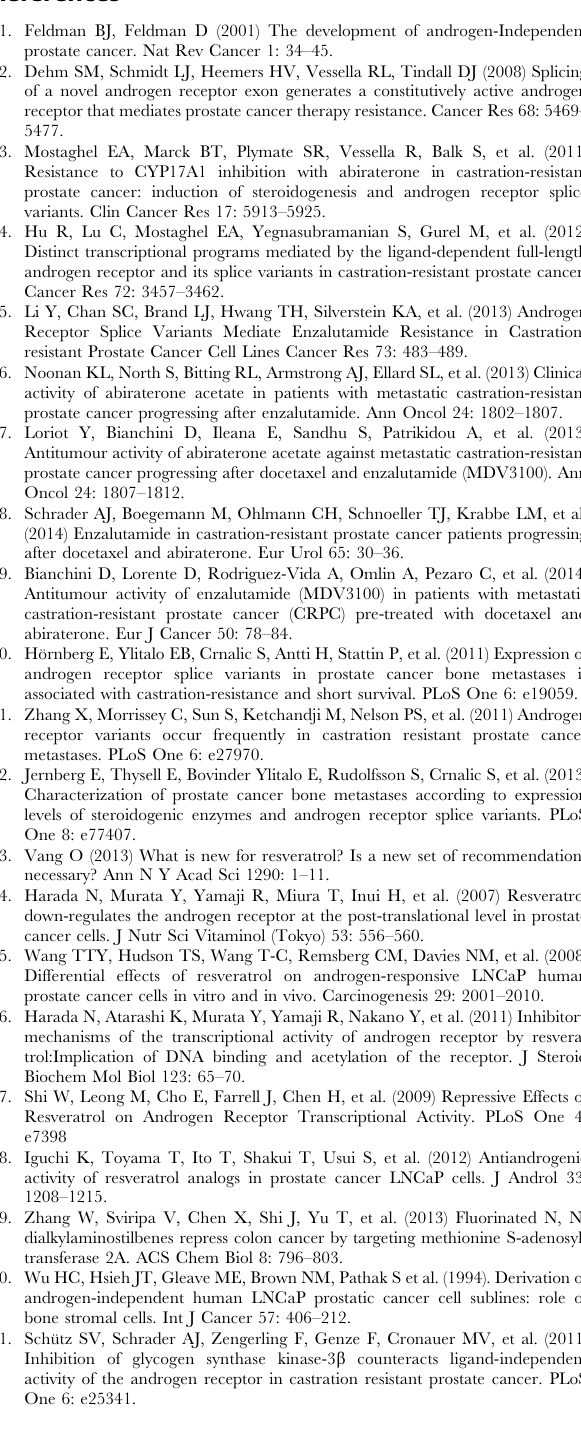
Table S1 Effects of RSV and FIDAS on the cell viability in vitro